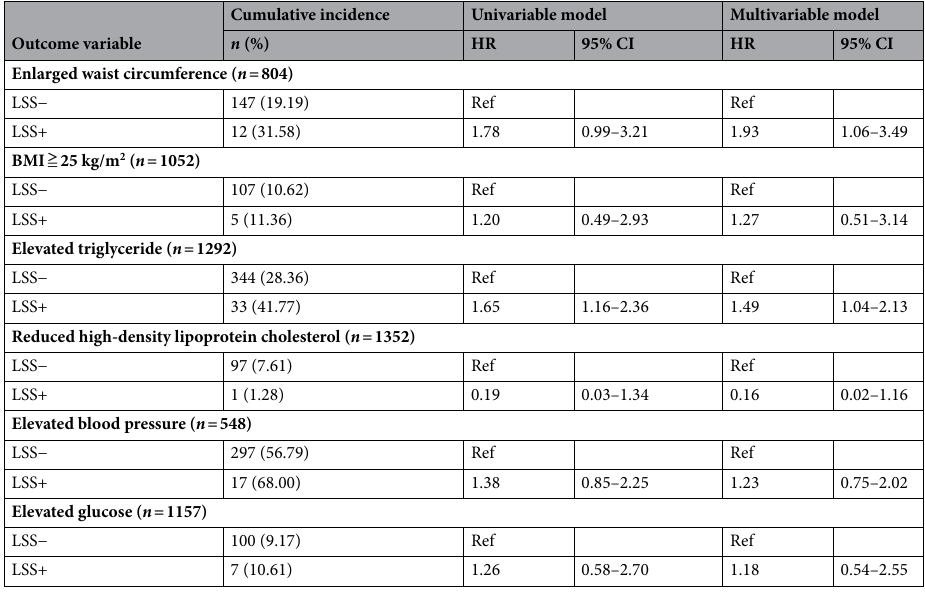
Table 4. Relationship between lumber spinal stenosis and the incidence of the metabolic syndrome components and body mass index in participants without each component at baseline. The primary explanatory variables in all models was lumbar spinal stenosis. Each model was analyzed without the prevalence of each component. Cox regression analysis was used to complete missing data. All models were adjusted for age, sex, smoking status, alcohol consumption, number of metabolic syndrome components at baseline and mental health. Enlarged waist circumference: ≥ 80 cm in females or ≥ 90 cm in males; elevated triglyceride level: ≥ 150 mg/dL, or taking a drug prescribed for high triglycerides; low high-density lipoprotein cholesterol: < 50 mg/dL in females or < 40 mg/dL in males, or taking drugs prescribed for low high-density lipoprotein cholesterol; elevated blood pressure: systolic blood pressure ≥ 130 mmHg and/or diastolic blood pressure ≥ 85 mmHg, or being under antihypertensive drug treatment; elevated glucose: hemoglobin A1c ≥ 5.6% or taking a drug prescribed for elevated glucose. BMI body mass index, LSS lumbar spinal stenosis, HR hazard